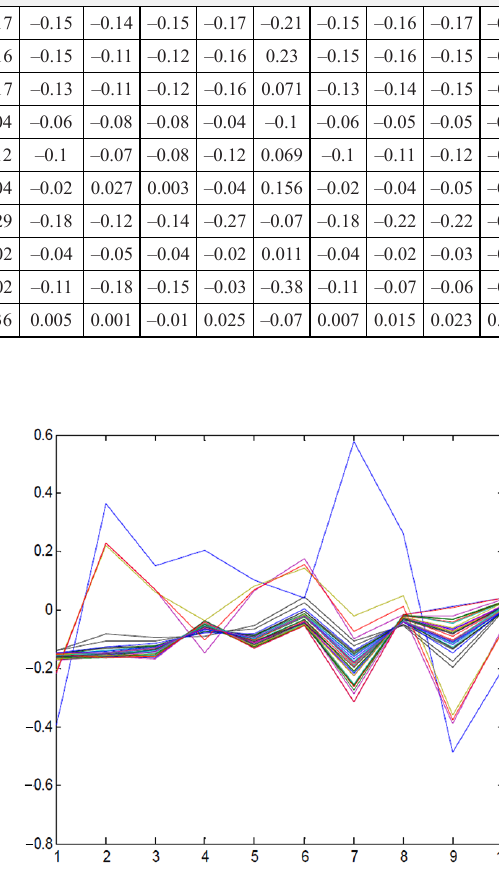
Fig. 1A. Changing of weights in neural